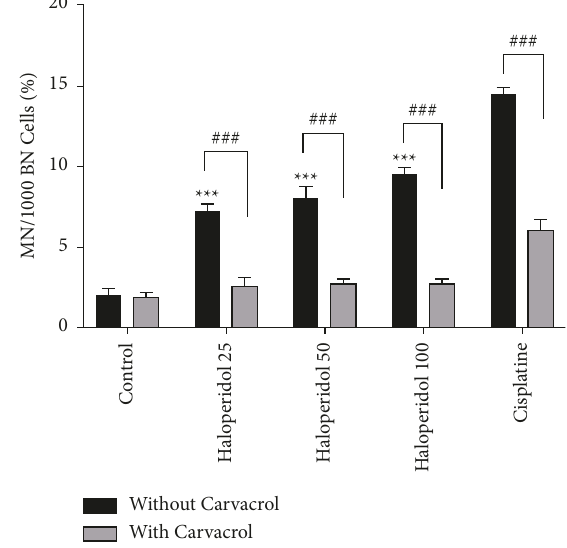
Figure 2: The protective effect of carvacrol on haloperidol-induced genotoxicity in MN frequency in human lymphocytes; values are presented as the mean ± SD; ∗∗∗ significantly different compared to the control group without carvacrol ( P < 0 . 001); ###significantly different in comparison with the haloperidol-treated group without carvacrol ( P < 0 .